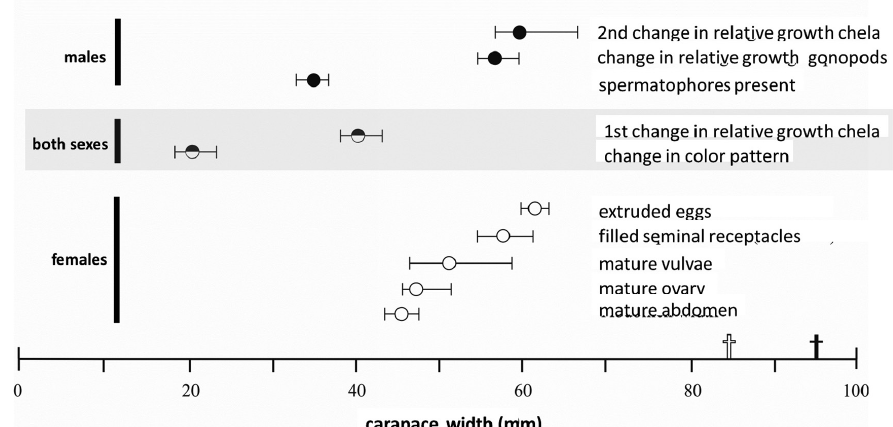
Fig. 8. – Graphic summary of noteworthy events of the post-settlement phase of male and female Platyxanthus crenulatus . Size of primiparous females is shown as mean value; size at gonad first maturity and spermathecae and vulvae maturation are CW determined by the logit 50% function fitted to the proportion of individuals having the mature version of the respective maturity indicator. Horizontal bars correspond to 95% CI for each